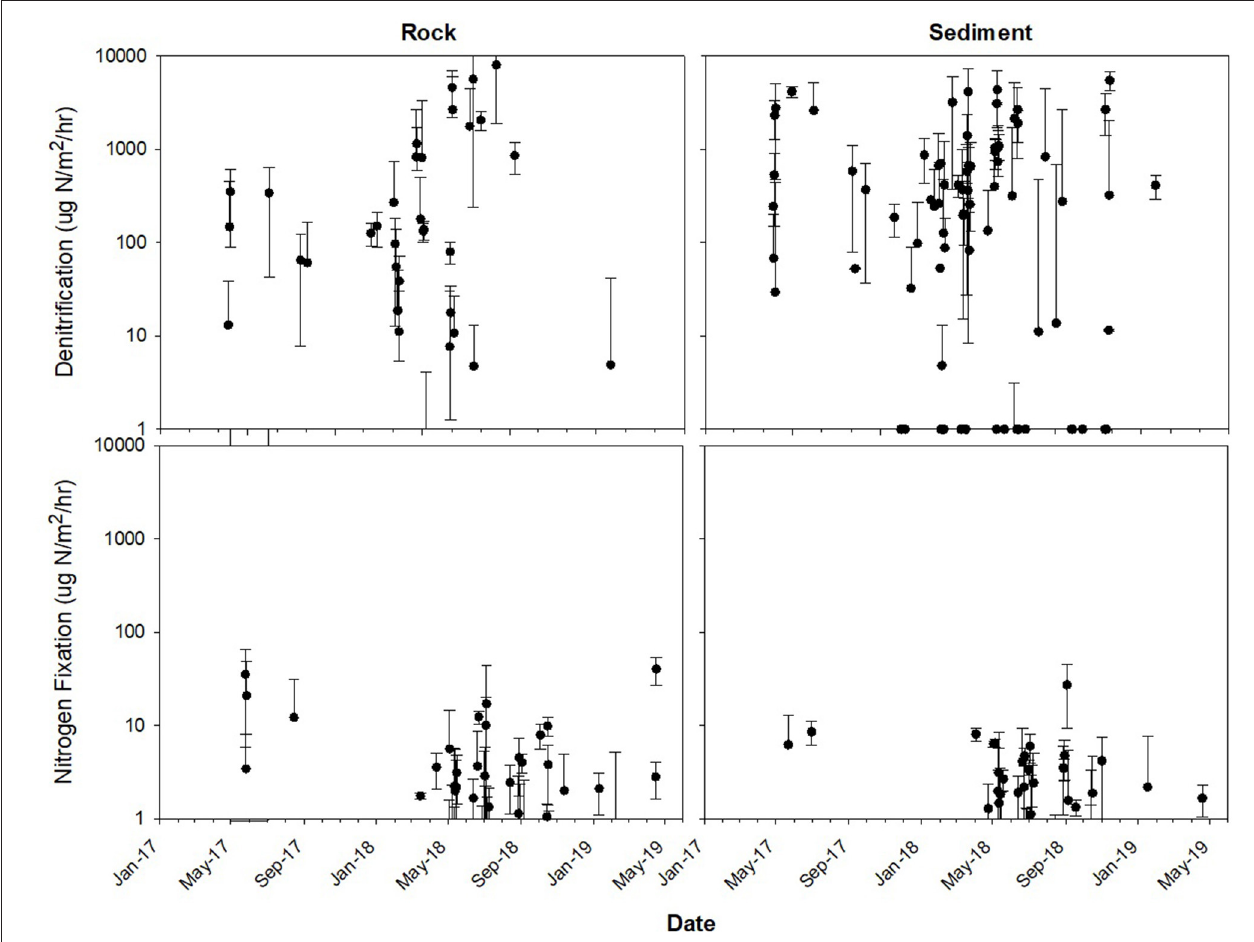
FIGURE 3 | Rates ± standard deviation for denitrification (top) and N 2 fixation (bottom) on rocks (left) and in sediment (right). Sampling occurred every 2–6 weeks year-round between May 2017 and May 2019. Additionally, once per season sampling occurred every day over a 1–2-week